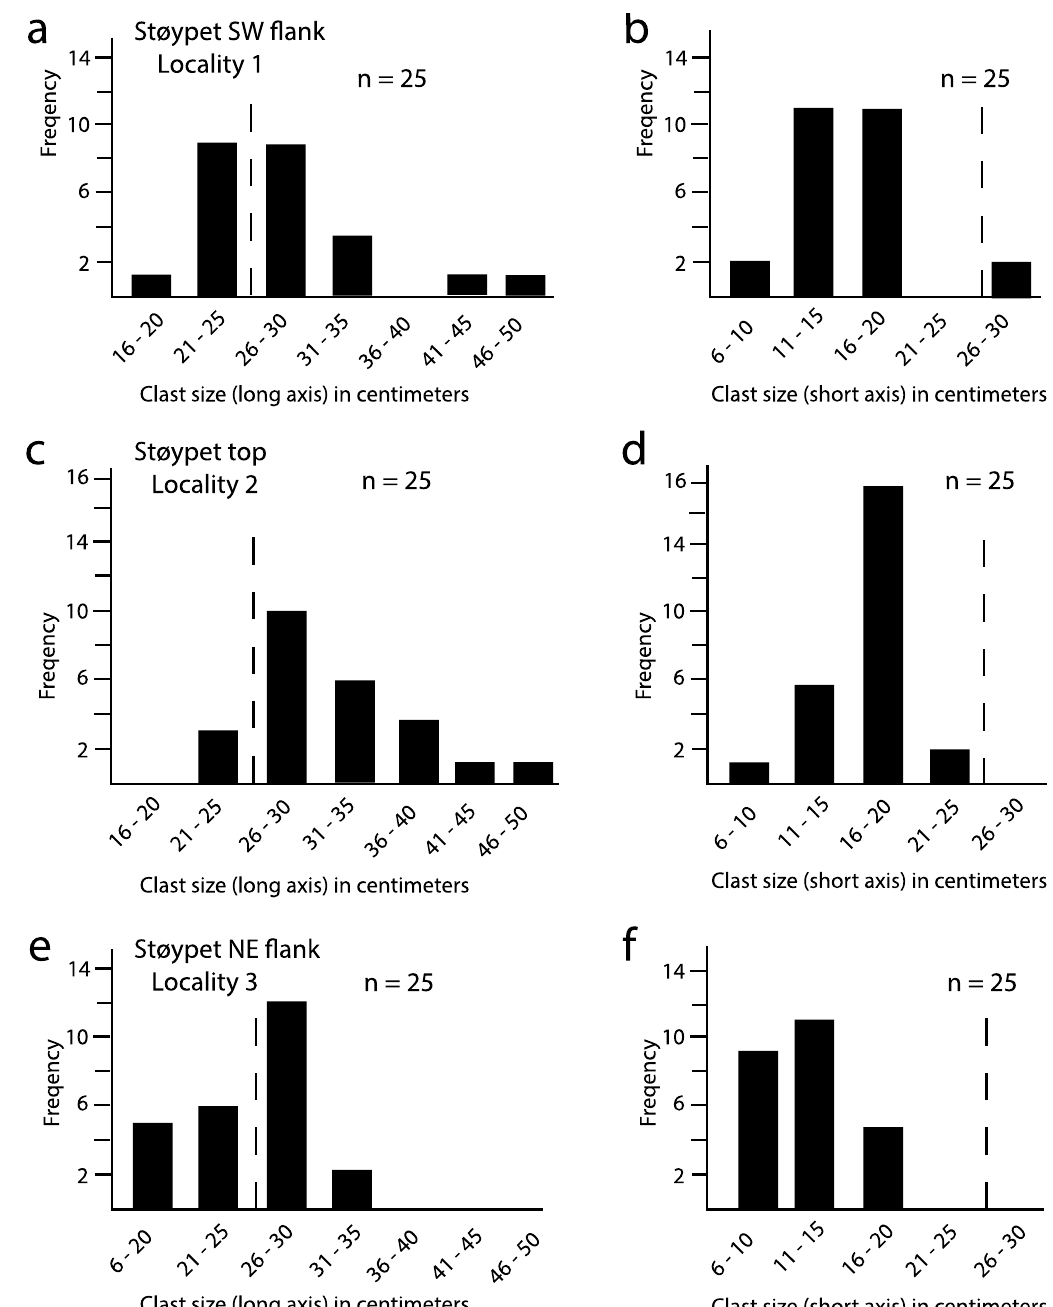
Figure 9. Set of bar graphs used to contrast variations in maximum and minimum clast length from three samples in Støypet valley: ( a , b ) bar graphs from Locality 1 on the SW flank of the deposit, ( c , d ) bar graphs from Locality 2 at the top of Støypet, and ( e , f ) bar graphs from Locality 3 on the NE flank of the deposit. Dashed line (offset to represent 26.6 mm) marks the boundary between large cobbles and small boulders.